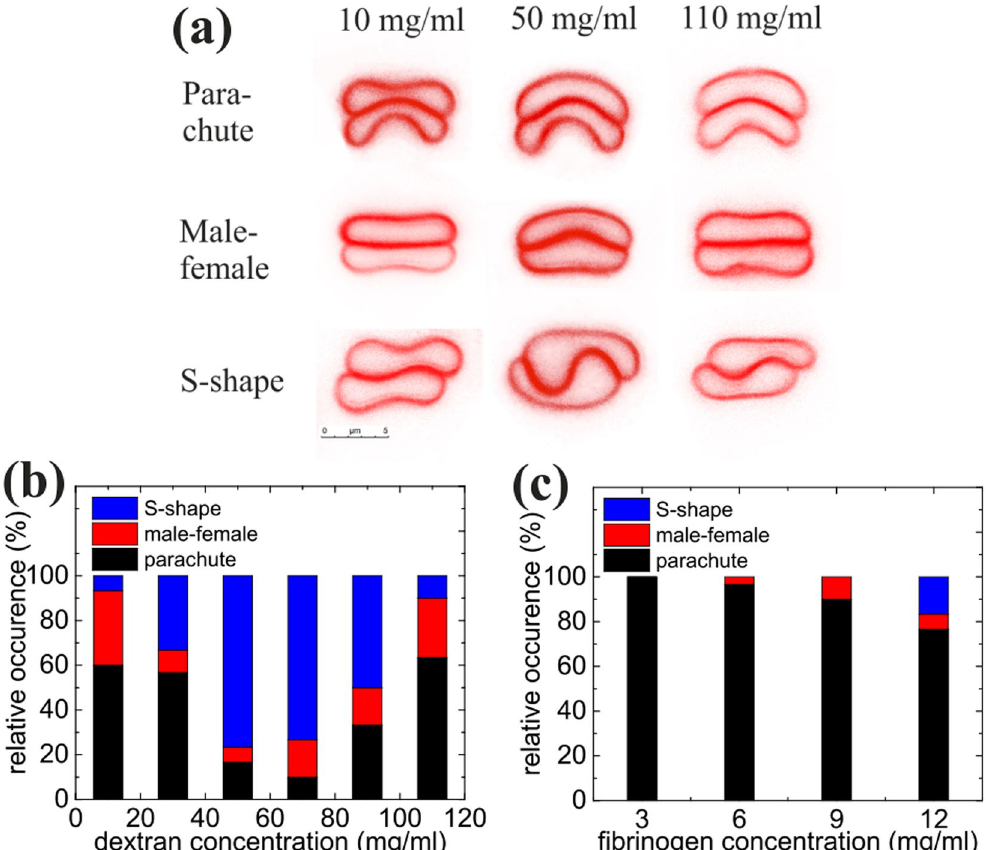
Figure 2. ( a ) Representative shapes of sedimenting doublets for different concentrations of dextran. At each concentration three different types of shapes can be identified: parachute, S-shape and male-female shape. ( b ) Distribution of male-female, parachute and S-shapes for different concentrations of sedimenting cells in discocyte shape in dextran solutions. ( c ) Distribution of male-female, parachute and S-shapes for different concentrations of sedimenting cells in discocyte shape in fibrinogen